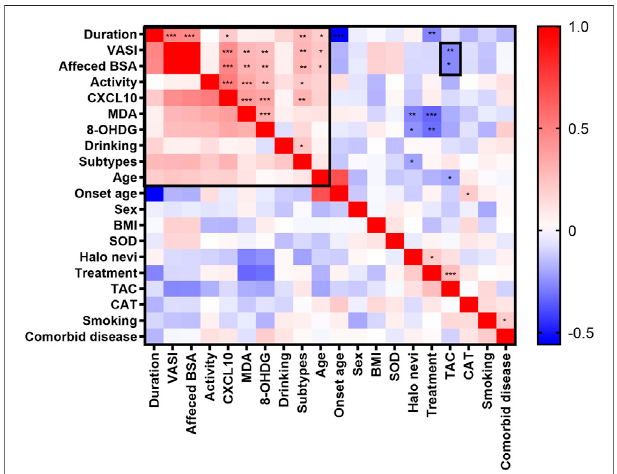
FIGURE 3 | The correlation heatmap of clinical characteristics and serum OS markers by using Pearson correlations. The heatmap showing the positive (red) or negative (blue) correlations of all parameters with color intensity re fl ecting the strength of the correlation ( − 0.56 to +1). OS, oxidative stress. * p < 0.05; ** p < 0.01; *** p < 0.001.